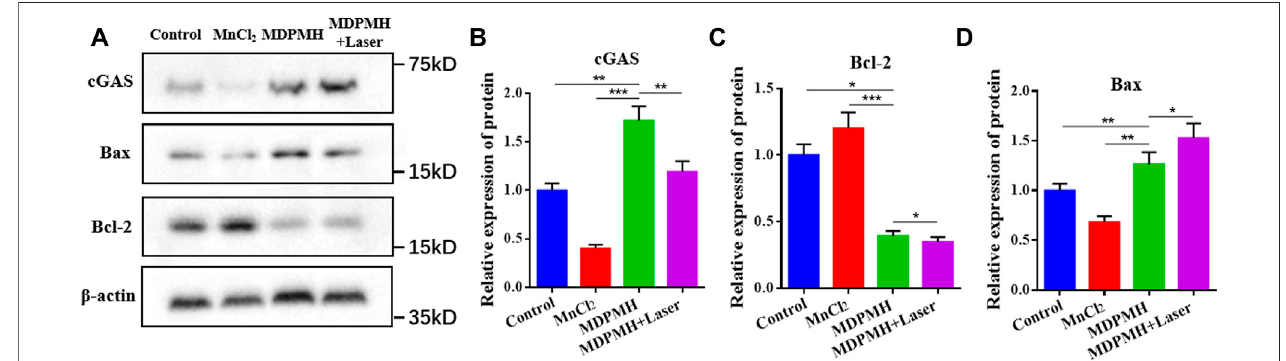
FIGURE8|(A) WesternblotanalysisontheexpressionofcGAS,Bax,andBcl-2inA549cellsafterincubationwithControl,MnCl 2 ,MDPMH,andMDPMH+Laser; β -actin was selected as internal reference protein. The relative expression of different proteins, cGAS (B) , Bax (C) , and Bcl-2 (D) . * p < 0.05, ** p < 0.01, *** p <